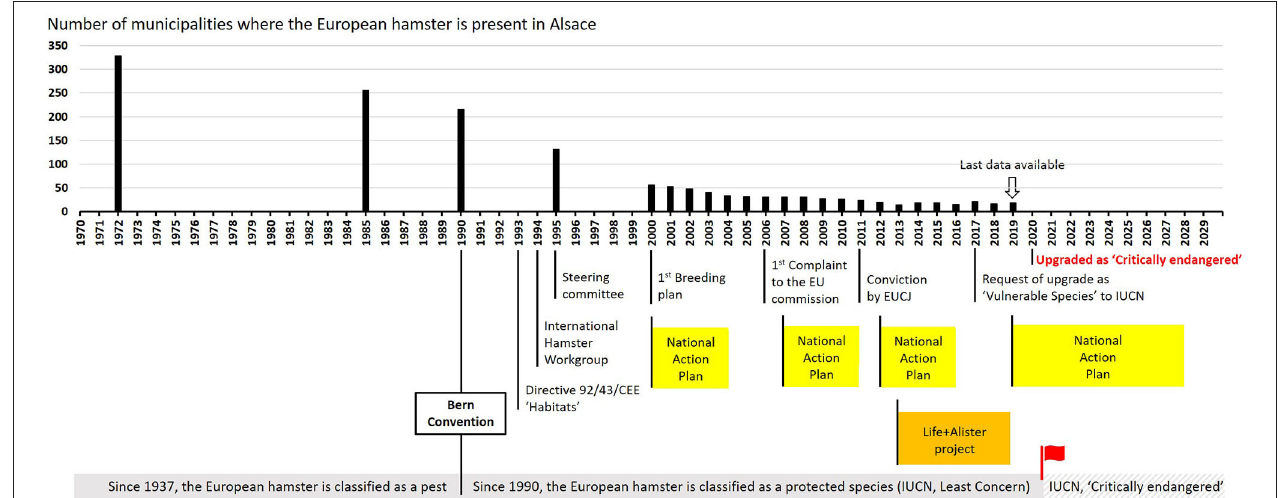
FIGURE 1 | Hamster conservation in Alsace: from the evolution of its presence to conservation plans between 1970 and 2028. Bars represent the number of municipalities where the European hamster is present in Alsace (France). The lower part of the figure represents the timeline of principal events concerning conservation measures and decisions for the